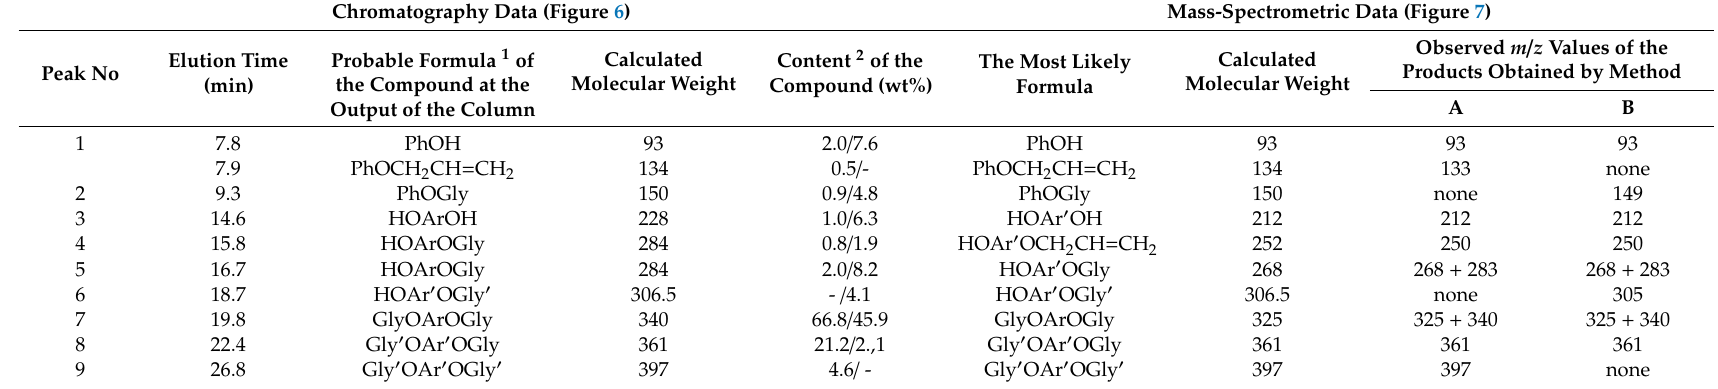
Table 2. Results of chromatography-mass spectrometric analysis of organic fractions of reaction products obtained according to schemes A and B. Molar ratio of HCP:phenol:bisphenol A = 1:3:5.